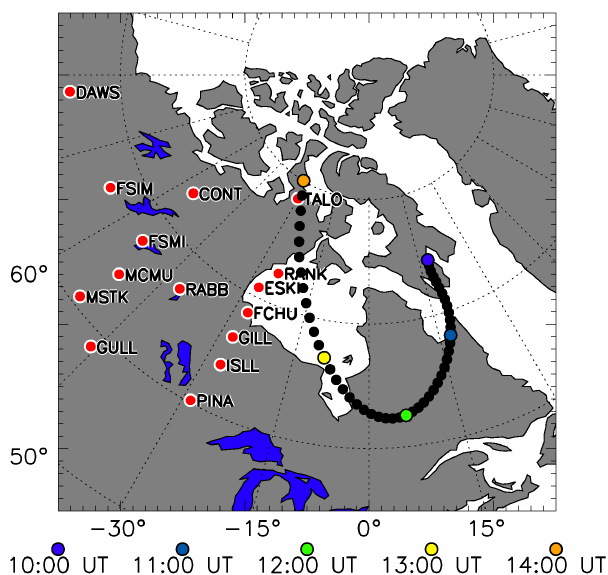
Fig. 6. Unlagged magnetic magnitude and particle data measured by the ACE satellite.